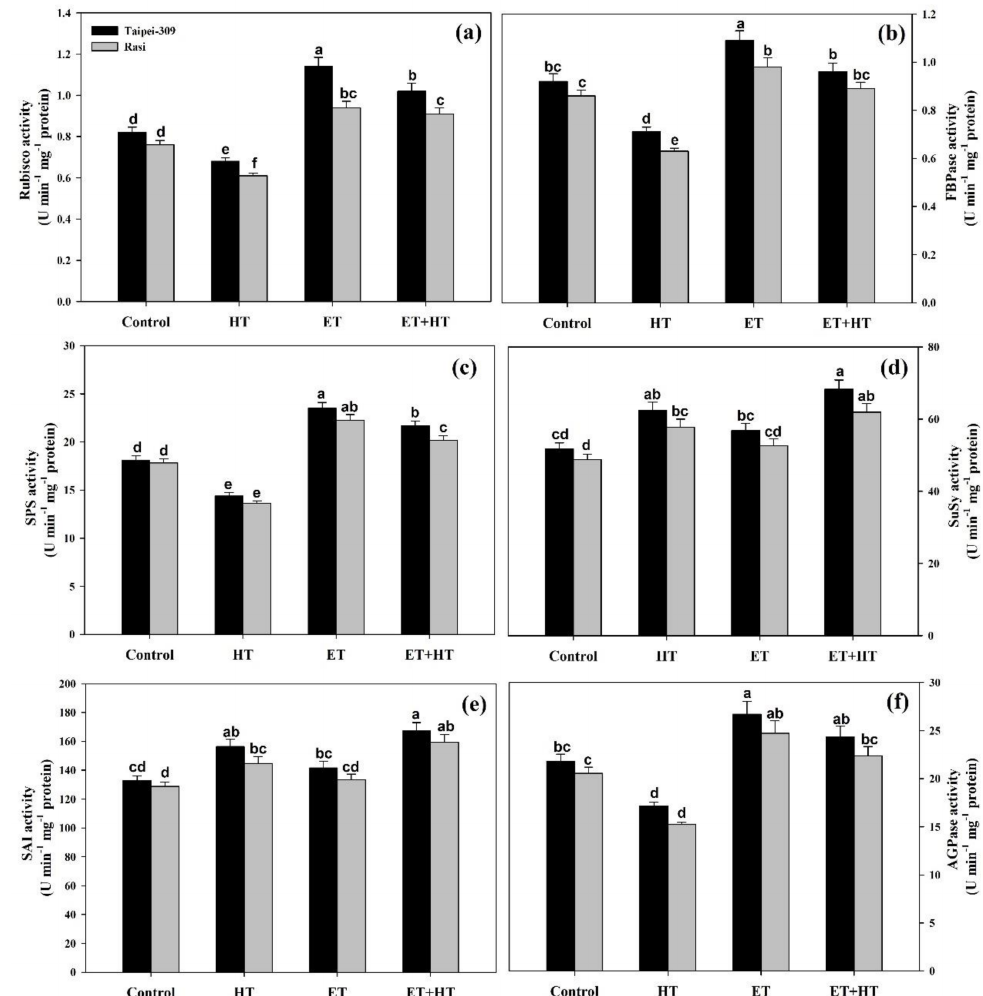
Figure 5. Ribulose 1,5-bisphosphate carboxylase/oxygenase (Rubisco) activity ( a ), fructose bisphos- phatase (FBPase) activity ( b ), sucrose phosphate synthase (SPS) activity ( c ), sucrose synthase (SuSy) activity ( d ), soluble acid invertase (SAI) activity ( e ), and ADP-glucose pyrophosphorylase (AGPase) activity ( f ) in Taipei-309 and Rasi cultivars of rice ( Oryza sativa L.) at 30 DAS. Plants were grown with/without high-temperature (HT) stress and treated with a foliar spray of 1.6 mM ethephon (ET) at 15 DAS.Data are presented as treatment means ± SE ( n = 4). Bars with the same letters did not differ significantly by the LSD test at p < 0.05. DAS, days after